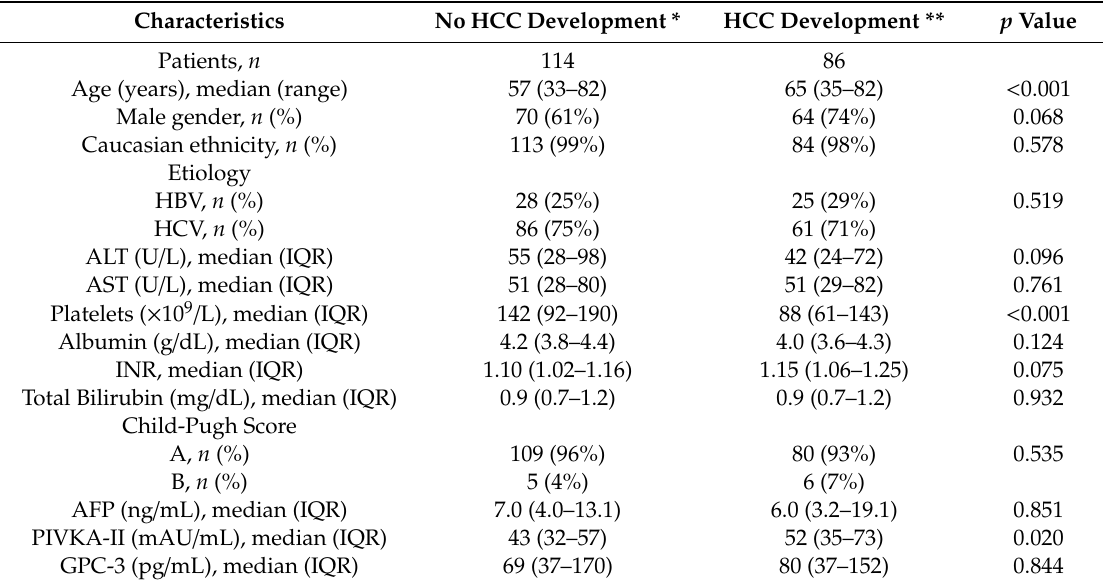
Table 5. Characteristics of the patients with cirrhosis that developed or not HCC during 36 months of